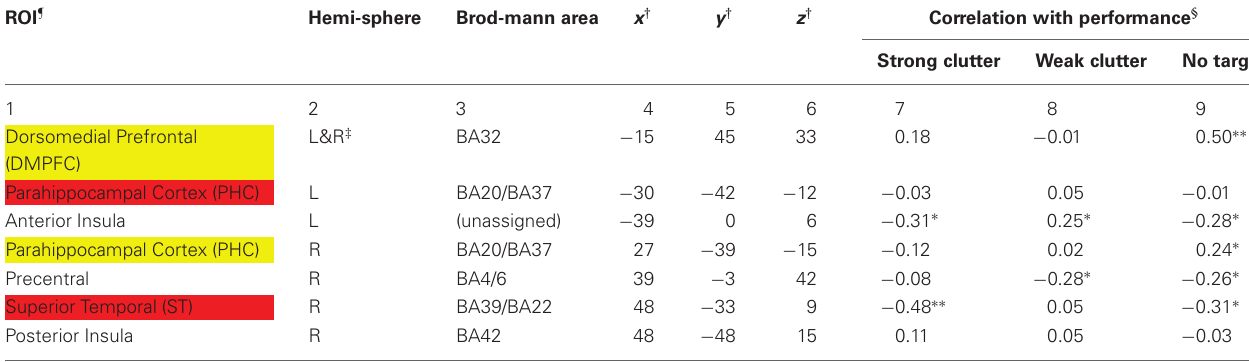
¶ ROIs highlighted in green, red, or yellow denoted brain regions whose activity correlated with the recognition of objects learned in strong clutter, objects learned in weak clutter, or both types of objects, as determined by logistic regression at the level of stimulus types. The BOLD responses used in the models were estimated using the Condition-wise method (Method 1; Materials and Methods). This analysis was separate from the behavioral level analyses shown in columns 7–9. See text for details. † The stereotactic coordinates represent the center of mass of the given ROI in the MNI space. ‡ ROIs that were contiguous because they were on the medial wall of the hemispheres were treated as a single ROI, i.e., the voxels were not partitioned into two hemispheres. § The numbers represent the correlation coefficient r between the estimated BOLD response of a given ROI to a given condition during each scan and the correspond- ing behavioral performance of the subject (measured as % correct trials). The BOLD responses during a given condition were estimated using the